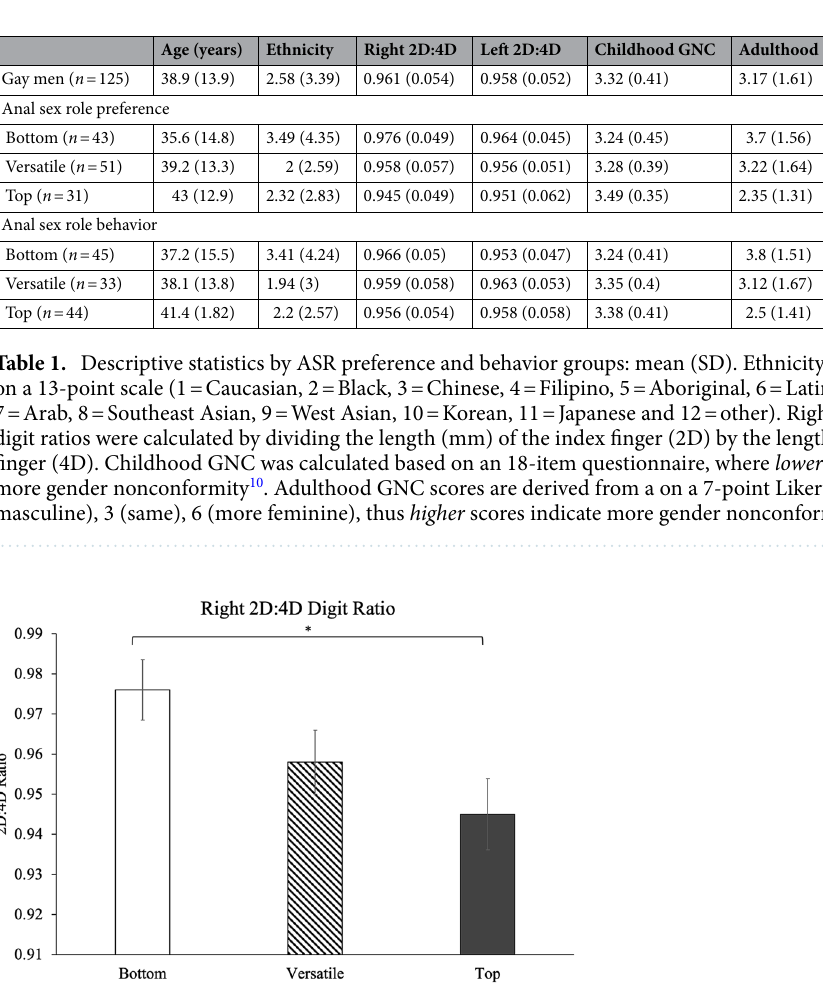
Figure 1. ASR preference groups differ in right digit ratios. ASR Bottoms have more female-typical (higher) right digit ratios than ASR Tops ( d = 0.62); Versatiles were intermediate, such that they did not significantly differ from either ASR Tops or Bottoms. *Significant difference, p <